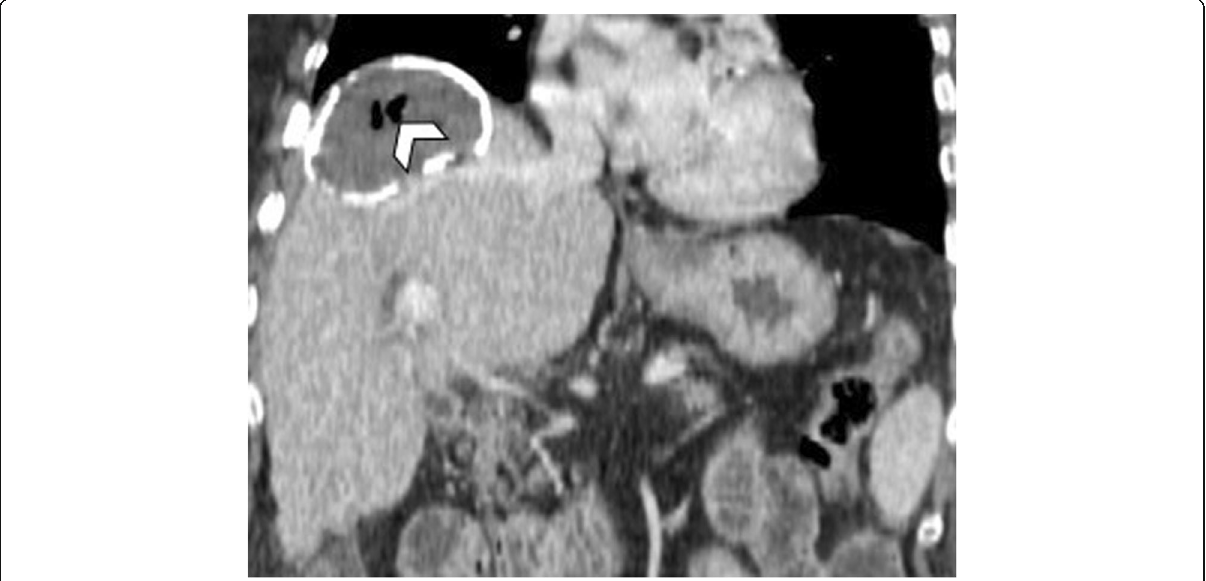
Fig. 6 A 54-year-old man with air content within a hepatic hydatid cyst. Coronal reformatted CT image on portal venous phase shows air bubbles (arrowhead) within a unilocular calcified hydatid cyst. This finding was suggestive of occult cysto-biliary communication, which was later confirmed at